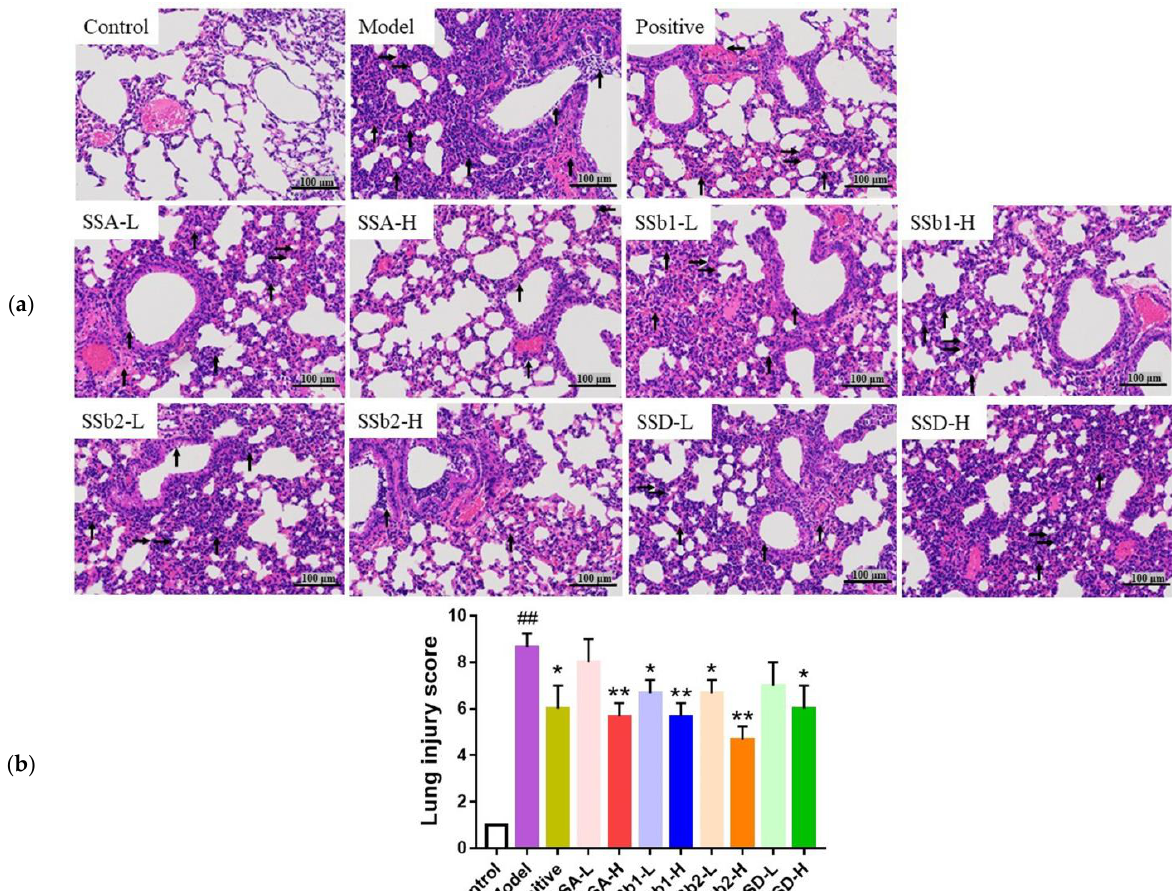
Figure 6. Representative images ( a ) and injury scores ( b ) of H&E-stained lung sections from LPS- induced ALI mice ( n = 3, means ± SDs). Magnification: × 200. Pathological indices involved in sections: inflammatory ( ↑ ), cellular hyperplasia ( → ), and hemorrhage ( ← ). Analyzed using a one-way ANOVA. ## p < 0.01 vs. control group; * p < 0.05, ** p < 0.01 vs. LPS-induced model group.